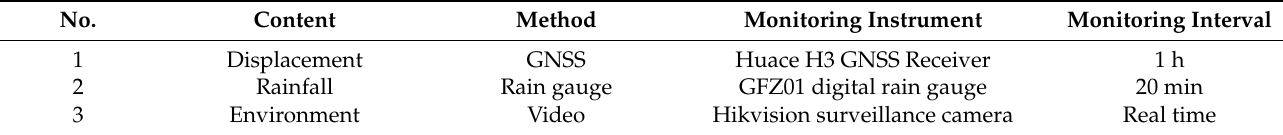
Figure 4. Location of the monitoring stations. Table 2. Monitoring system contents and